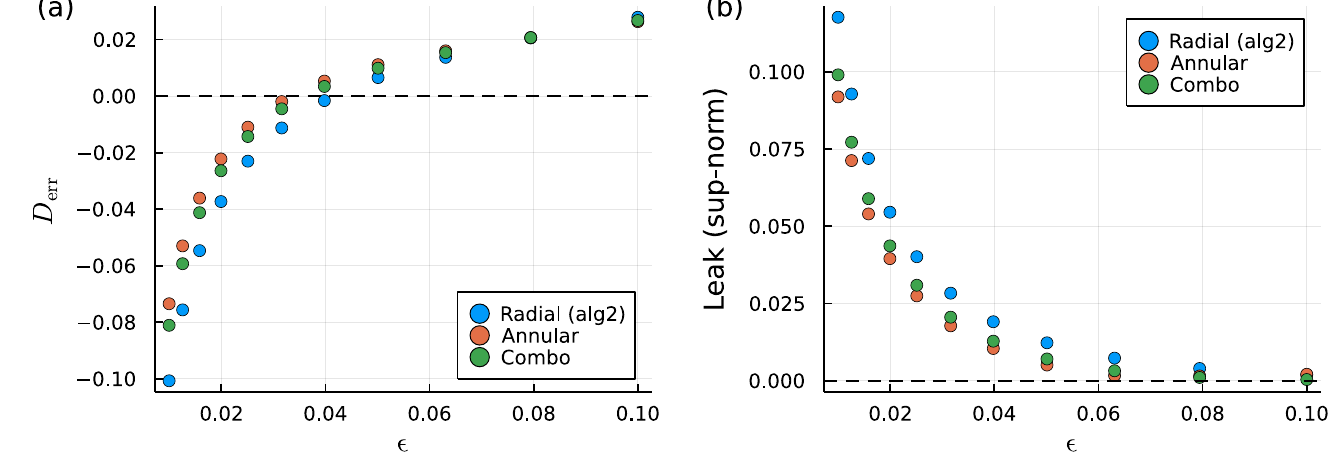
Figure 6. Error of surface oriented regularizations versus the radial alg2 regularization. The error in the drag is shown in ( a ) and the error in the boundary condition or “leak” at points on the surface of the sphere but in between the discretization points is shown in ( b